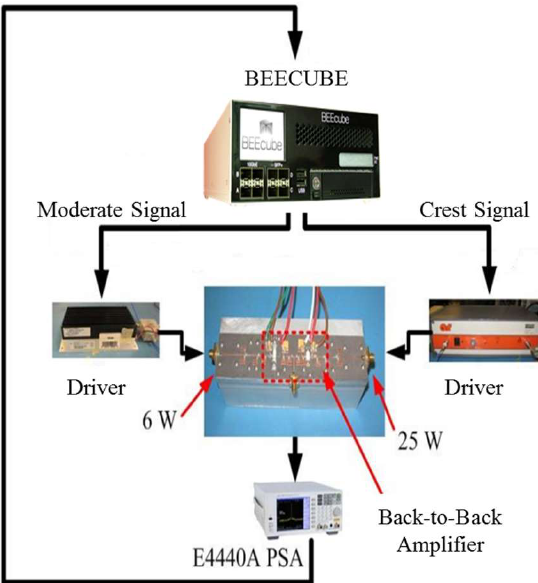
Figure 6. Dual-branch DSM setup.